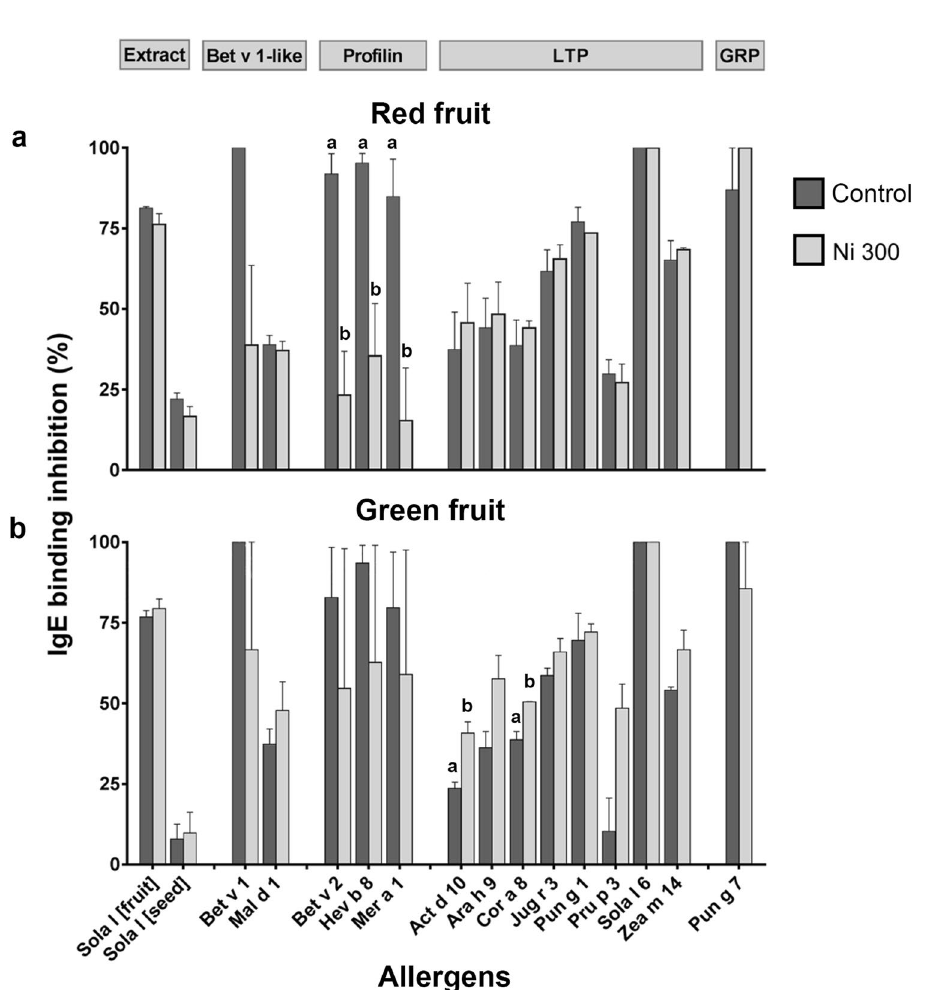
Figure 7. IgE Inhibition assays carried out with the tomato extracts of the ‘Standard’ cultivar using the FABER testing system with the SPHIAa method. Ripe—red ( a ) and unripe—green ( b ) tomatoes were probed with a mix of sera of patients sensitized to plant foods and used as providers of specific IgE. Untreated tomatoes are indicated with black columns, whereas Ni 300 treated samples are indicated with grey columns. Details of the analysed allergens are reported in Table 6. The values are duplicates reported as mean with range. Significant differences (obtained with Tukey’s post-hoc test) are marked with